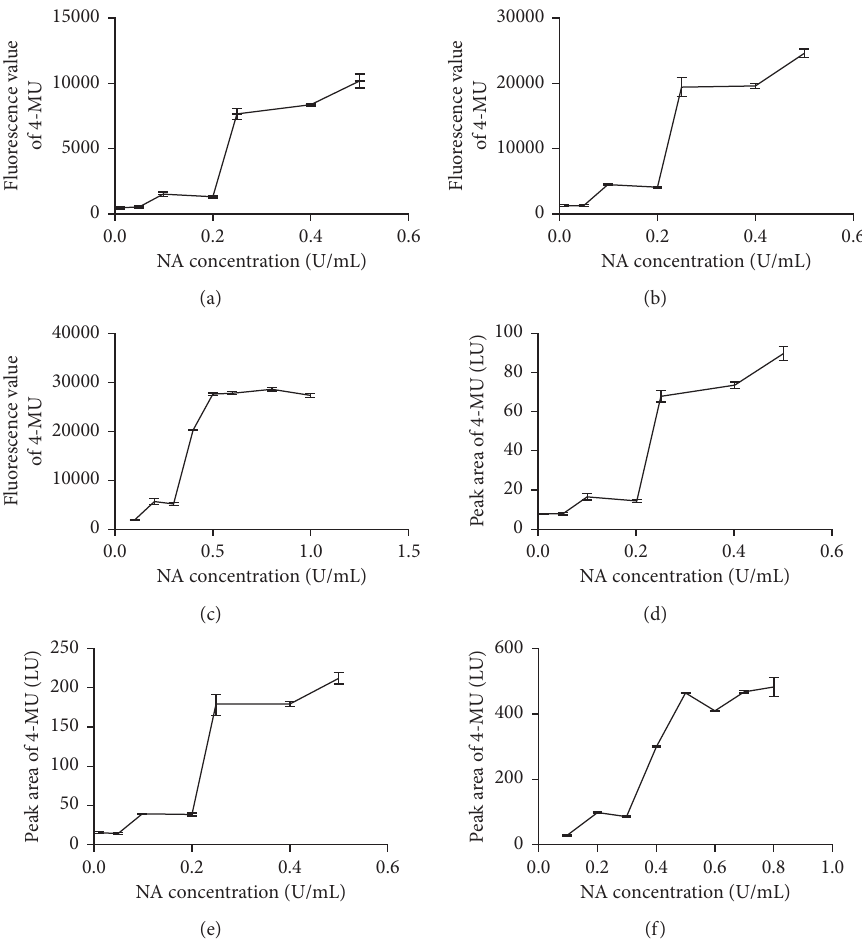
Figure 4: The effect of different NA concentrations and substrates on the fluorescence value and peak area of 4-MU by NA enzyme-based inhibitory assays and HPLC-FLD, respectively. (a) The effect of 10 μ g mL − 1 substrate on the fluorescence value of 4-MU, (b) the effect of 25 μ g mL − 1 substrate on the fluorescence value of 4-MU, (c) the effect of 50 μ g mL − 1 substrate on the fluorescence value of 4-MU, (d) the effect of 10 μ g mL − 1 substrate on the peak area of 4-MU, (e) the effect of 25 μ g mL − 1 substrate on the peak area of 4-MU, and (f) the effect of 50 μ g mL − 1 substrate on the peak area of 4-MU.